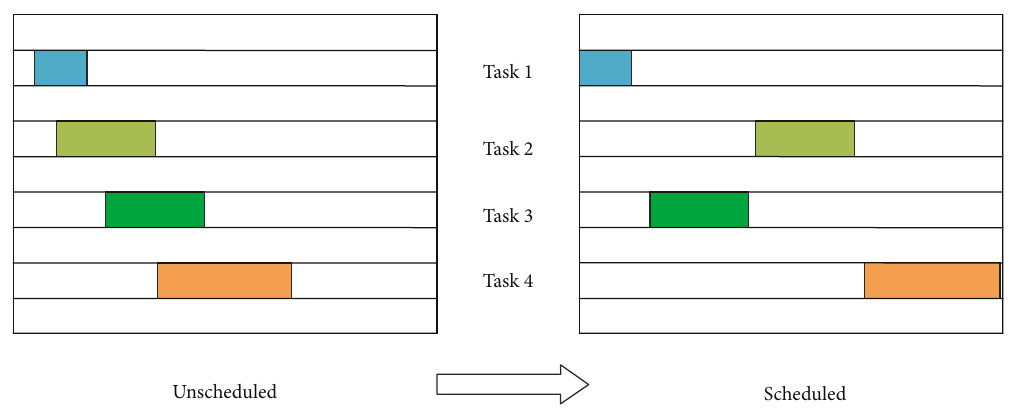
Figure 2: Downlink mission scheduling